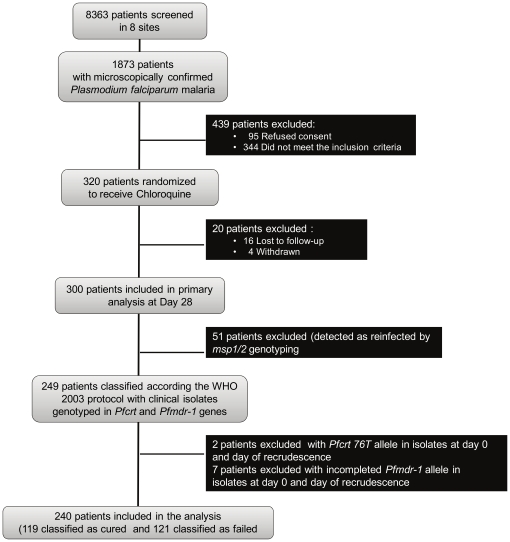
Flowchart of patients.Flowchart of patients: Enrollment, Randomization, Follow-up, Molecular genotyping.